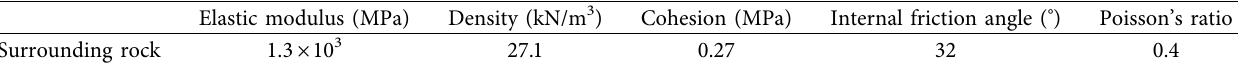
Figure 9: Establishment of the tunnel model. (a) Overall view of the tunnel model. (b) Diagram of the excavation. Table 2: Physical and mechanical parameters of the surrounding rock.